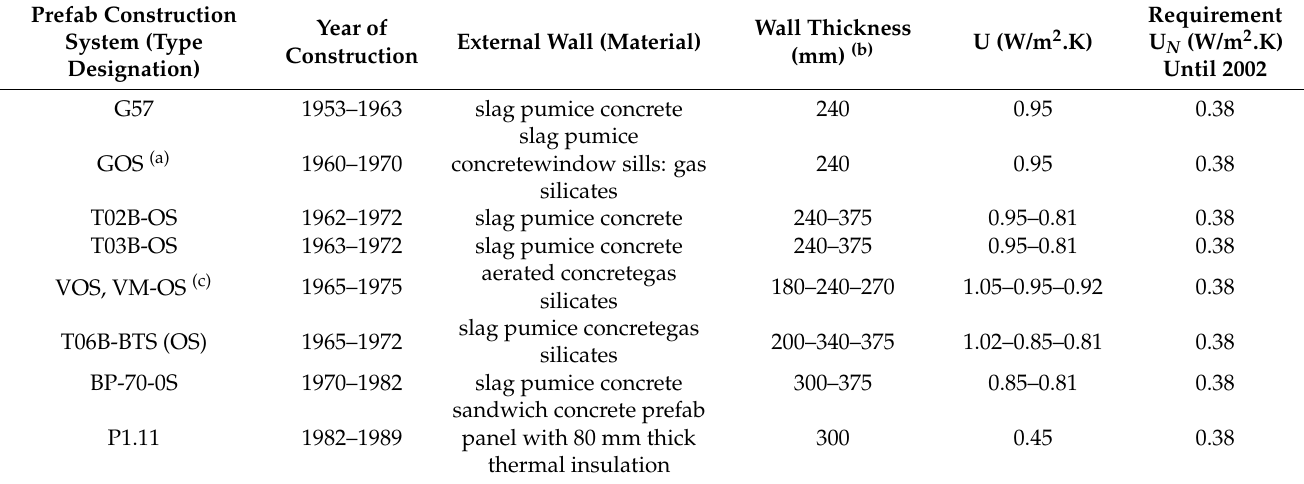
Table 4. Material solution of external walls of prefab residential housing buildings and U N requirements (examples of individual type construction systems in the Ostrava-Karvin á